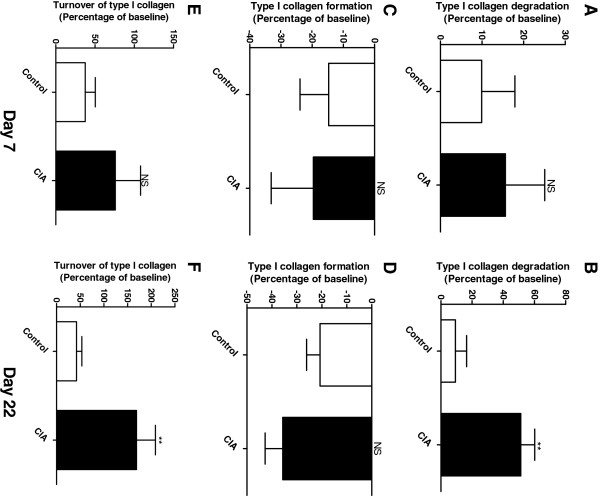
Biomarkers of type I collagen turnover on day 7 and 22 corrected to baseline. A, B: Type I collagen degradation detected with C1M. Range of measurement was [55.4-116.7]. C, D: Formation of type I collagen detected with P1NP. Range of measurement was [398.0-8603.1]. E, F: Calculations of type I collagen turnover. Range of measurement was [0.009-0.1]. The CIA group (black, n = 10) and control animals (white, n = 10) were compared by Mann–Whitney t-test. All statistical analysis was calculated based on baseline corrected values. Data are shown as mean ± SEM and significance levels as *: P < 0.05, **: P < 0.01, ***: P < 0.001.